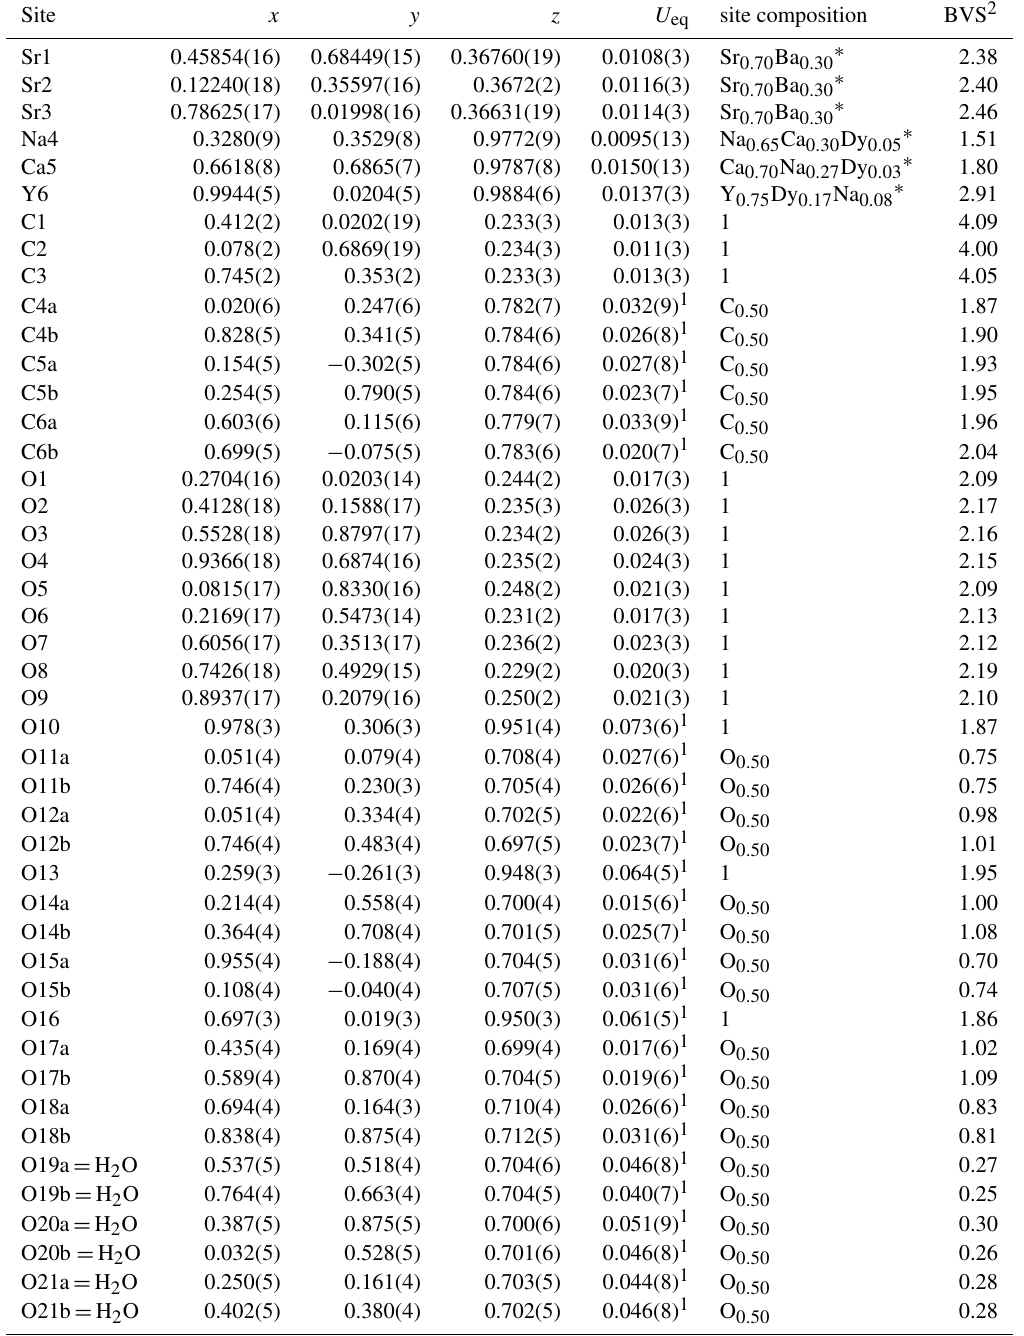
Table 6. Coordinates and equivalent displacement parameters ( U eq , in Å 2 ) of atoms, site occupancies, and bond valence sums (BVSs) for